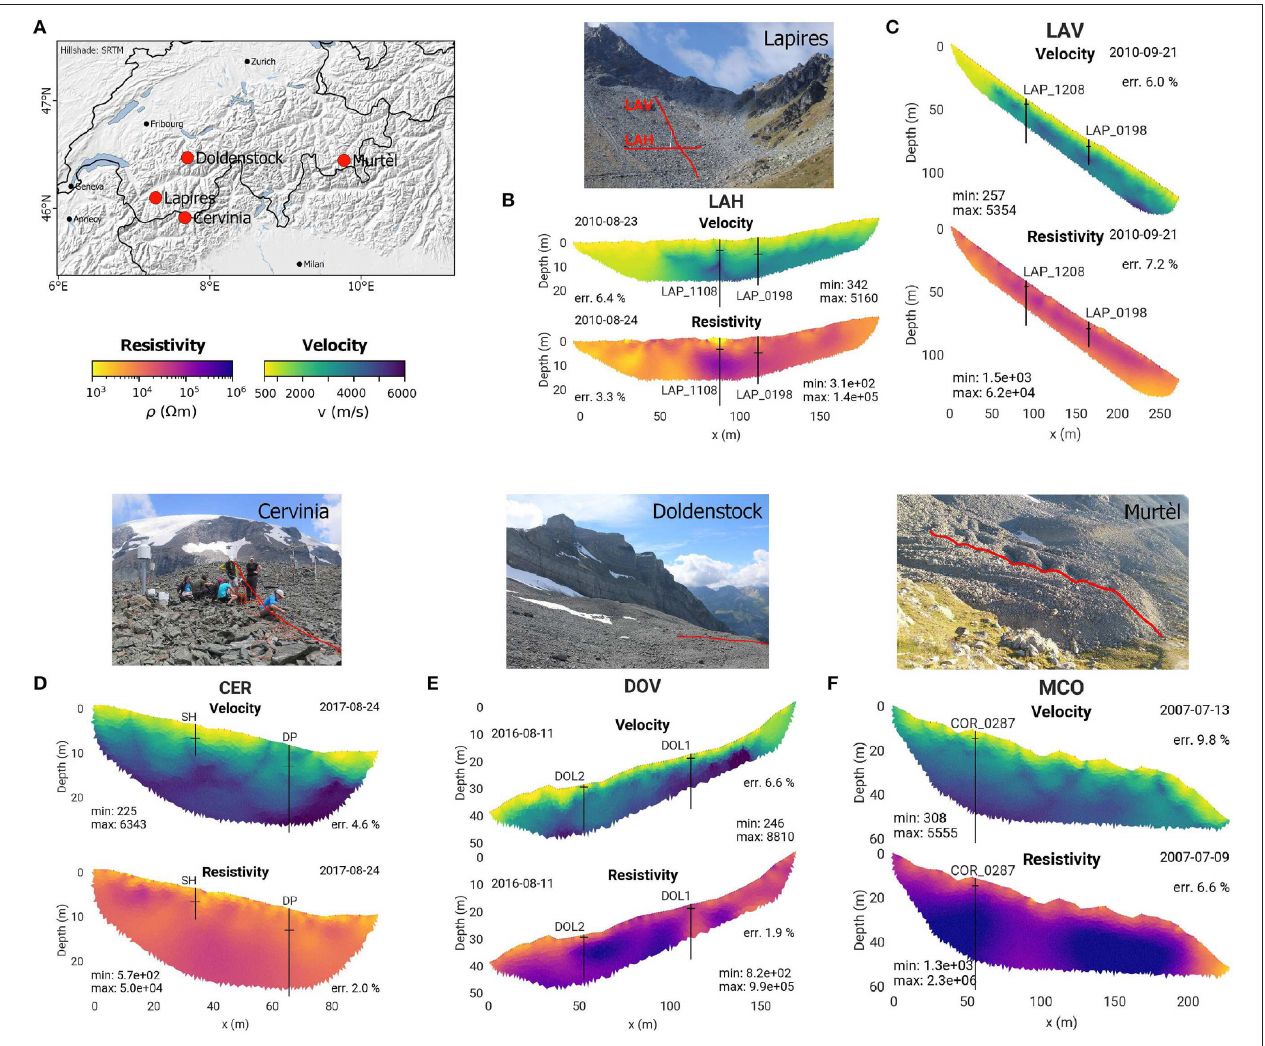
FIGURE 2 | (A) Field site location map, field site photographs with red lines indicating the geophysical profile position, and electrical resistivity and refraction seismic tomograms (individual inversions) for (B) LAH, (C) LAV, (D) CER, (E) DOV, and (F) MCO. In the tomograms, the vertical axis is exaggerated by 50% for a better readability. The individual RMS error of each tomogram is indicated nearby, as well as the date of measurements and the minimum and maximum values of the tomograms. Black lines indicate the borehole and thaw layer